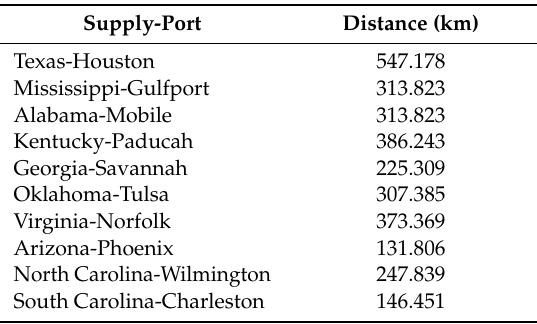
Table A2. Road distances between Supply and Port locations